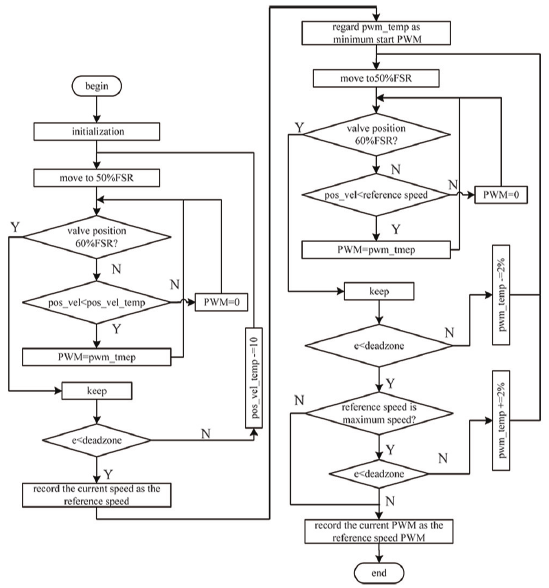
Figure 13. Self-identification flowchart of the reference speed and reference